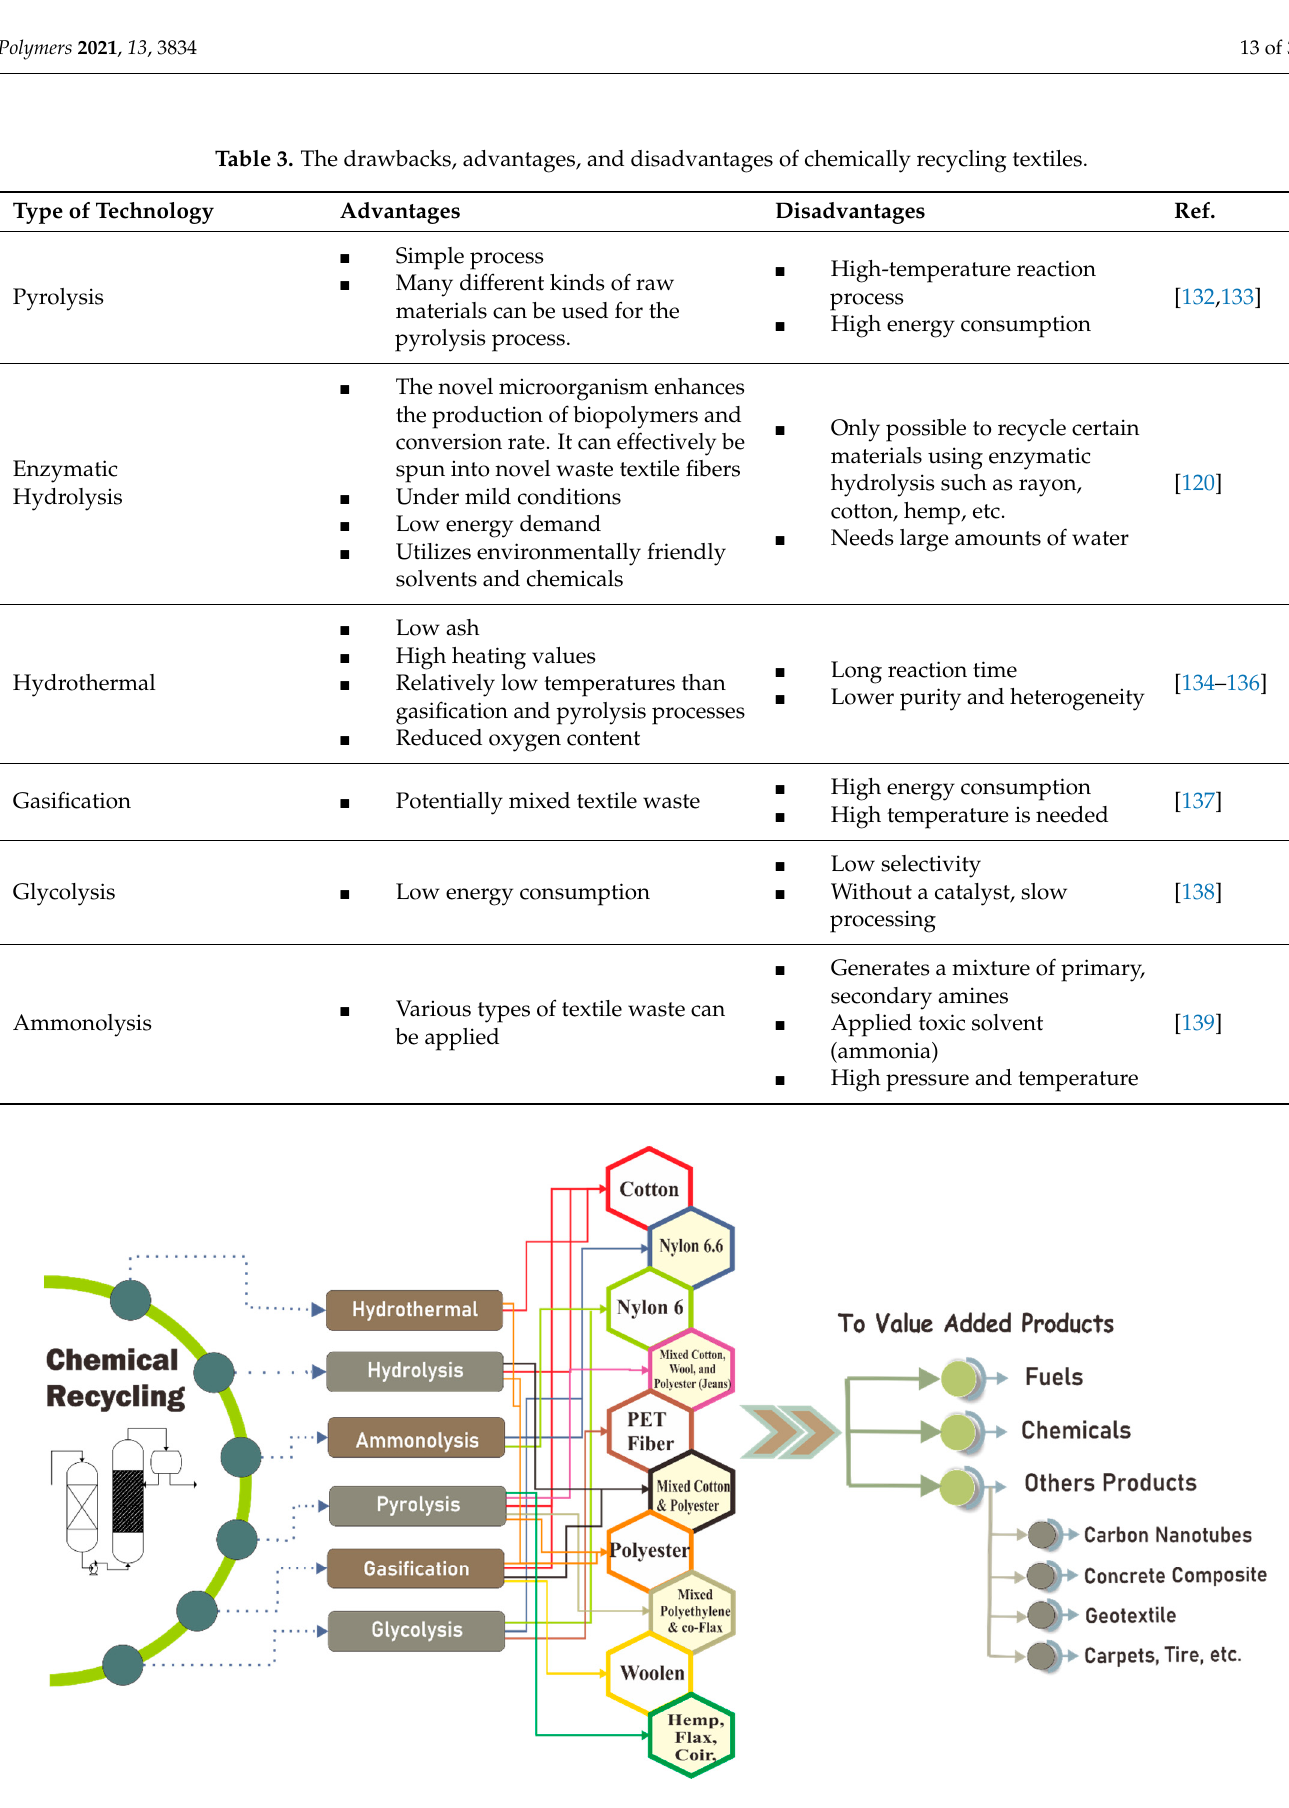
Figure 5. The possible pathways to recycling textiles using chemical